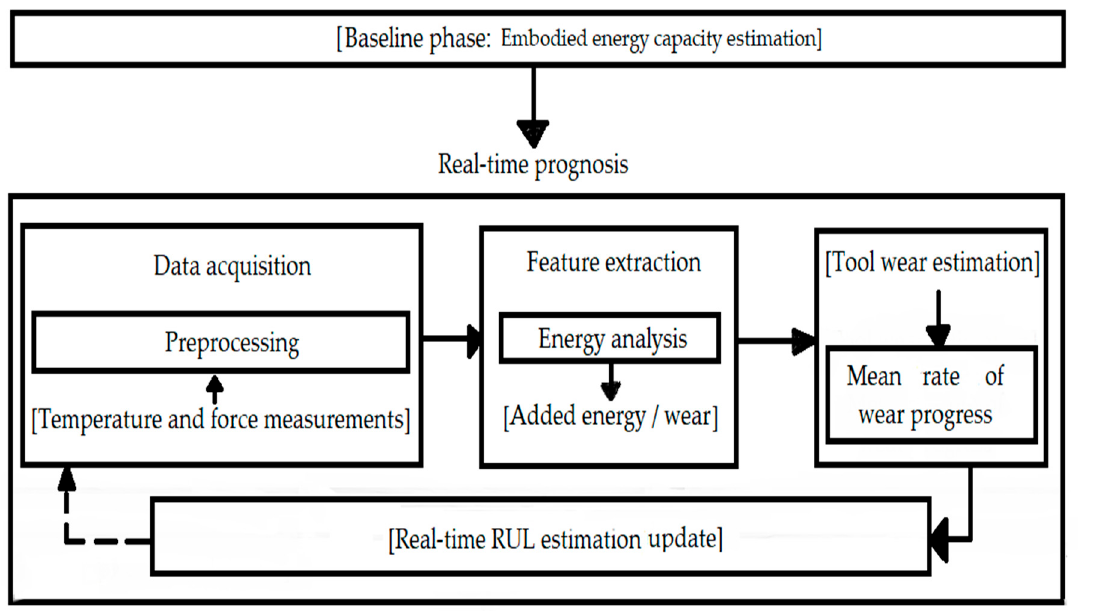
Figure 2. Flowchart of the proposed approach.